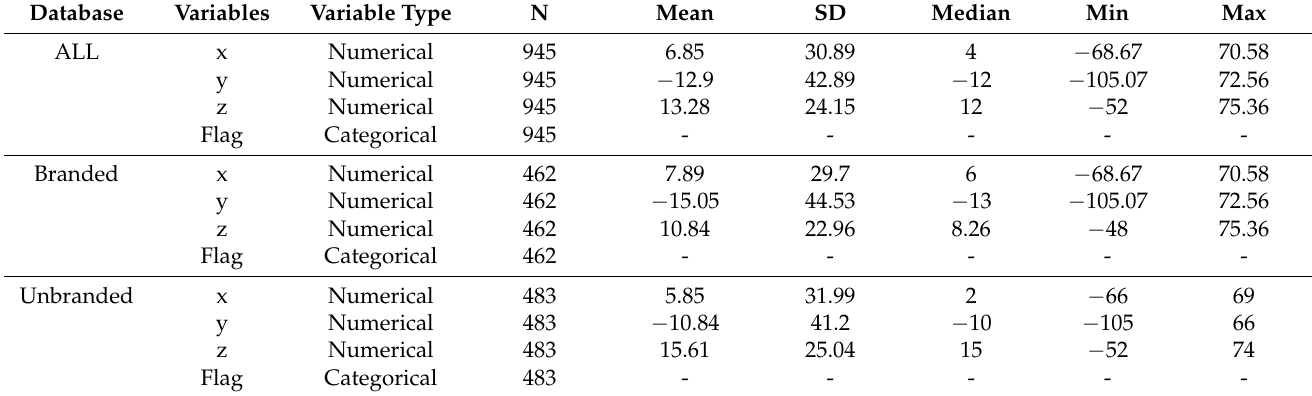
Table 5. Descriptive statistics (after feature engineering).